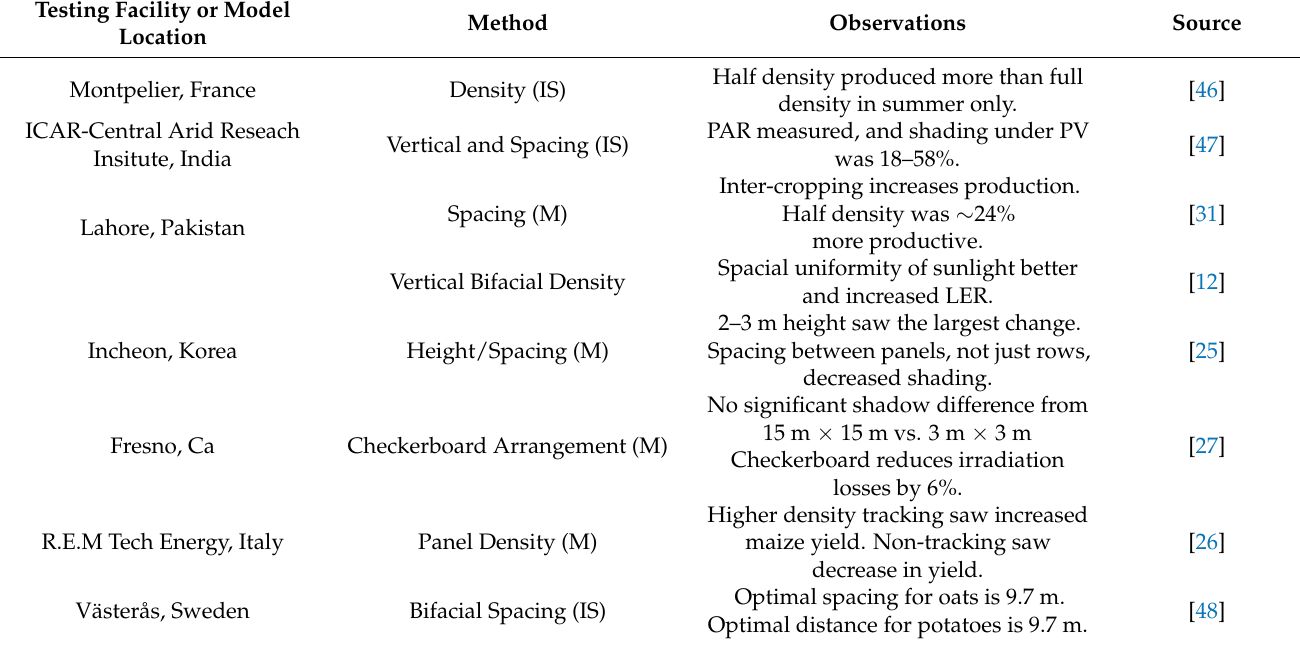
Table 2. Comparison of different layout methods tested: IS — In situ, M — Model.